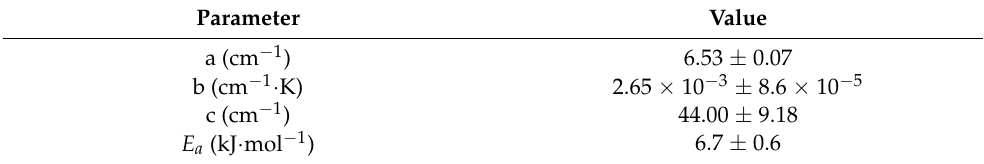
Figure 14. Temperature evolutions of FWHM of the band at 434 cm − 1 associated with the N–CH 3 bending mode. The solid line represents fitting of Equation (3) to the experimental data. Table 7. The fitted parameters: a, b, c, and E a for the temperature dependence of FWHM of the infrared band at 434 cm − 1 , associated with the N–CH 3 bending mode obtained in the temperature range of 290–10 K for the N,N-dimethylglycine–chloranilic acid (DMG + –CLA − ) co-crystal (cm − 1